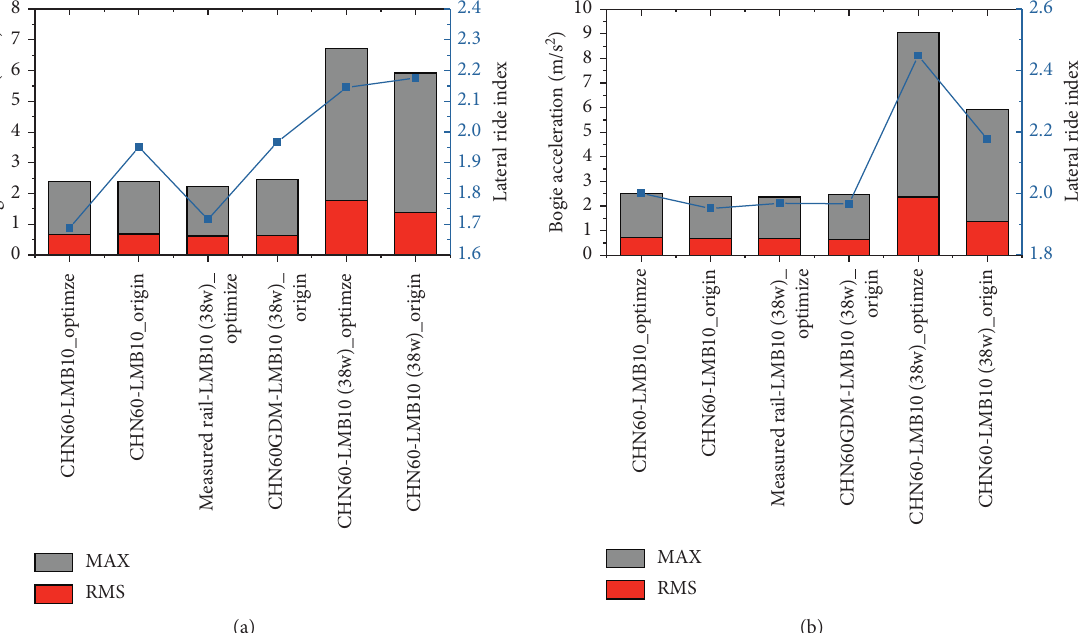
Figure 15: Vibration comparison between the optimized and original parameters. (a) Longitudinal stiffness of rotary arm attachment point and (b) yaw damper (MAX � maximum and RMS � root mean square).